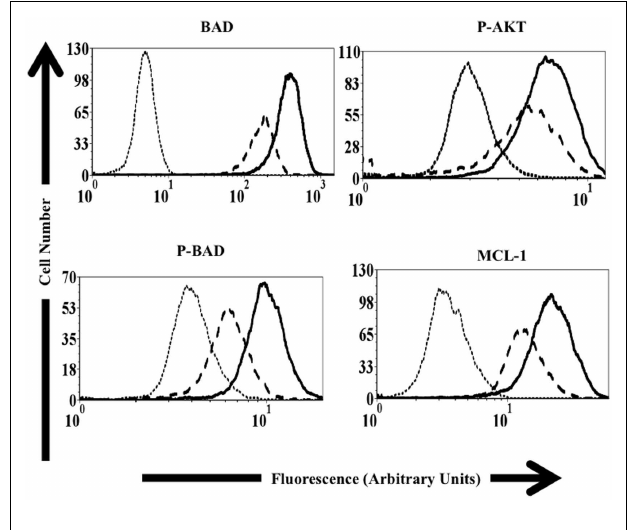
FIGURE 5 | Protein expression in control and MAP-infected macrophages. Representative histograms used to determine relative protein expression via flow cytometry as described in Materials and Methods.The dotted line represents isotype control samples (Samples exposed to only the secondary antibody).The dashed line represents data from MAP-infected macrophage populations. Solid black lines represent control, uninfected macrophage samples. Samples used to study p-AKT, BAD, and p-BAD were exposed to M-CSF prior to analysis. Samples used to study MCL-1 were exposed to GM-CSF prior to